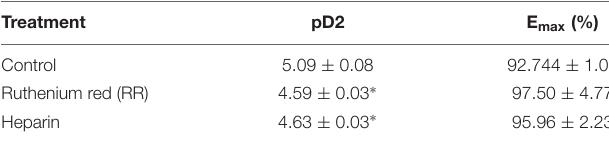
TABLE 2 | The effects of IP3 and Ryr receptor inhibitor on THP (1–100 µ M)-induced vascular relaxation in Ca 2 + free Krebs solution. Treatment